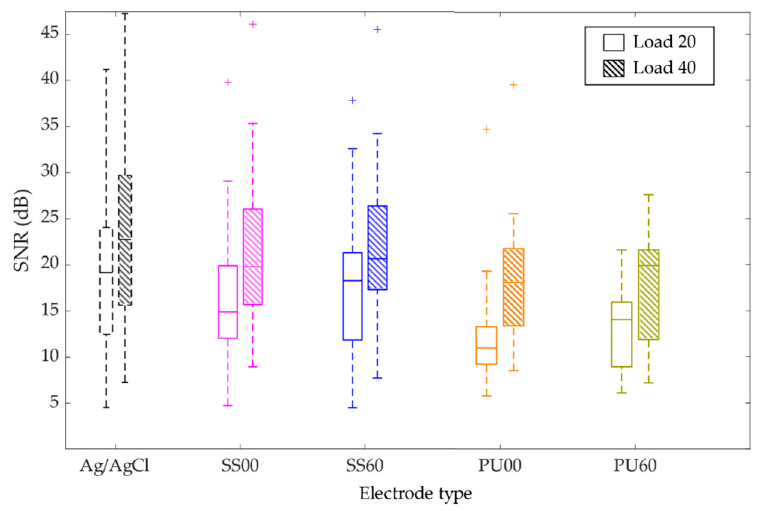
Figure 10. Signal-to-noise ratio (SNR) of the tested SS and TPU electrodes for the load of 20% and 40% of the volunteer’s maximum load.